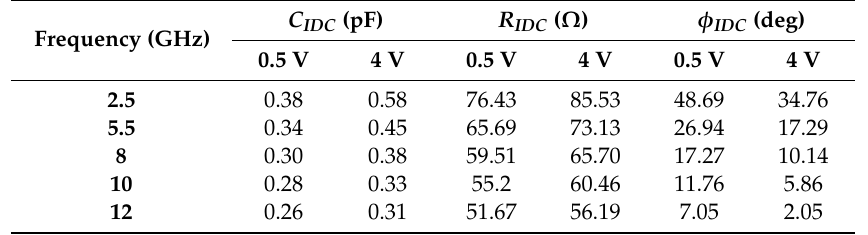
Figure 5. Measured capacitance (left vertical axis) and phase (right vertical axis) of the single interdigital capacitor at three reference frequencies (2.5 GHz, 5.5 GHz, and 10 GHz) for an applied DC bias voltage in the range 0–4 V. Table 1. Values of C IDC (pF), R IDC ( Ω ), and ϕ ID C (deg) at different frequencies for two values of the DC bias voltage.